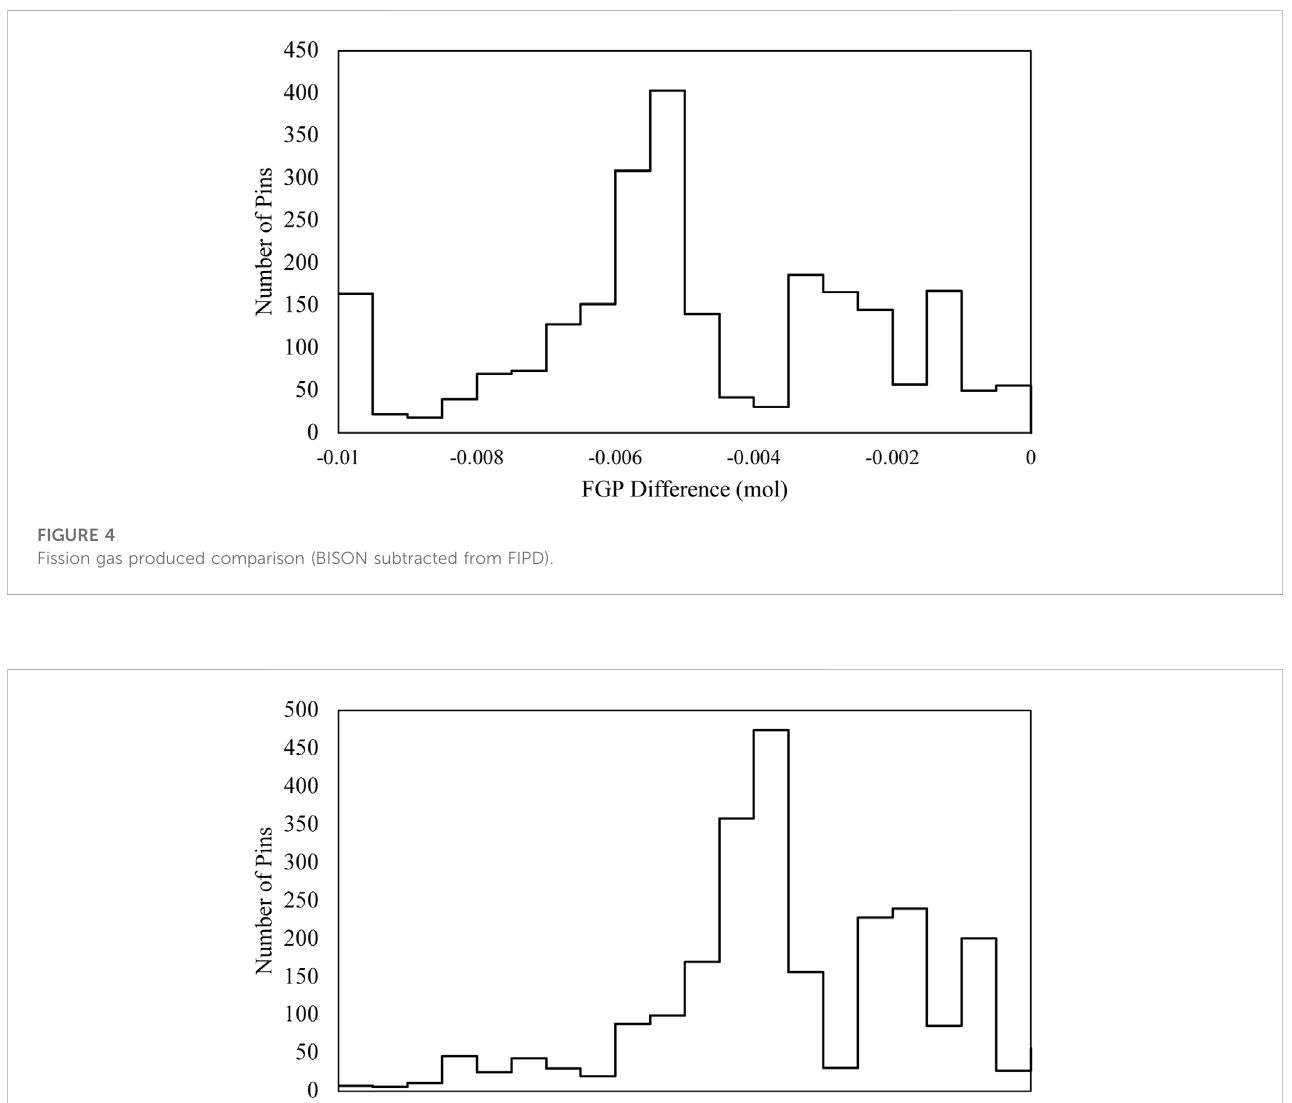
not being enabled, not accounting for operating cycle disruptions, and fi ssion energy from plutonium and plutonium production. FIPD use the average LHGRs recorded for a pin to calculate burnup, where BISON uses the average fi ssion rate density of the current and previous timestep (Paaren et al., 2021a).